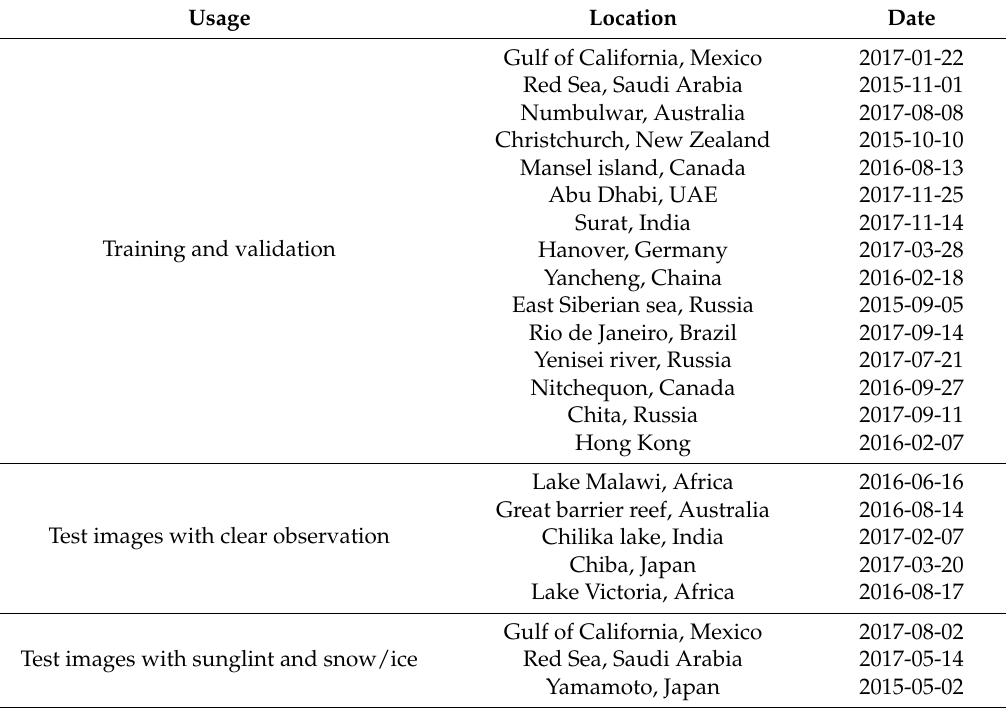
Table 1. Landsat-8 data used for training, validation, and